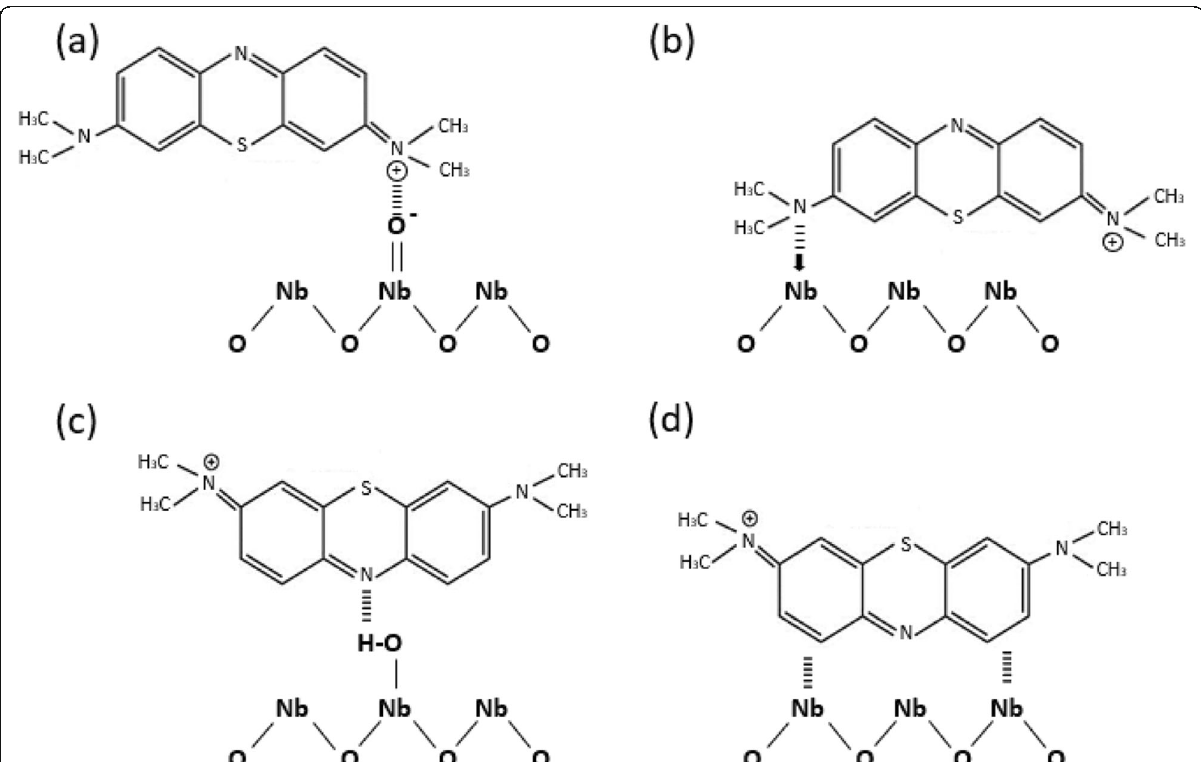
Fig. 7 MB molecule adsorption mechanisms over niobia surface. Ref.: ( a ) electrostatic interaction, ( b ) Lewis acid-base interaction, ( c ) hydrogen bond interaction, ( d ) interaction by delocalized π